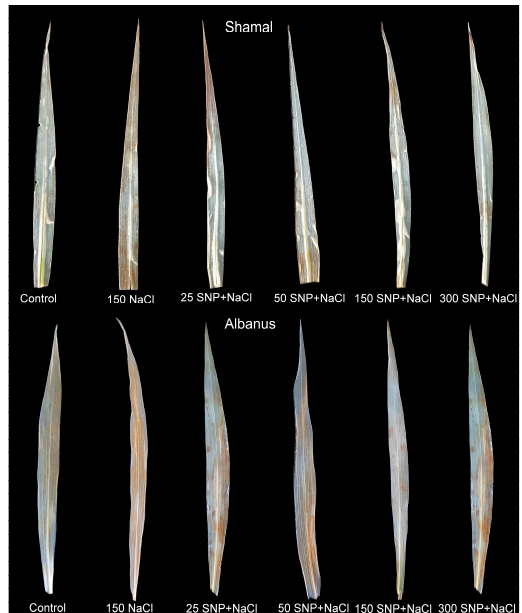
Figure 3. Histochemically detected accumulation of hydrogen peroxide (H 2 O 2 ) with diaminobenzene (DAB) in leaves of the two sorghum varieties (Albanus and Shamal) after foliar spraying with different SNP concentrations under salt stress.